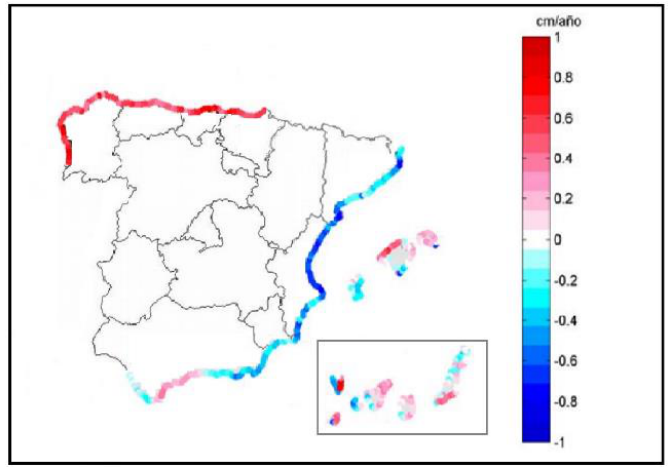
Figure 4. Trend of change of Hs 12 over the last 60 years, as observed in Spain. Adapted from Losada et al. [7].